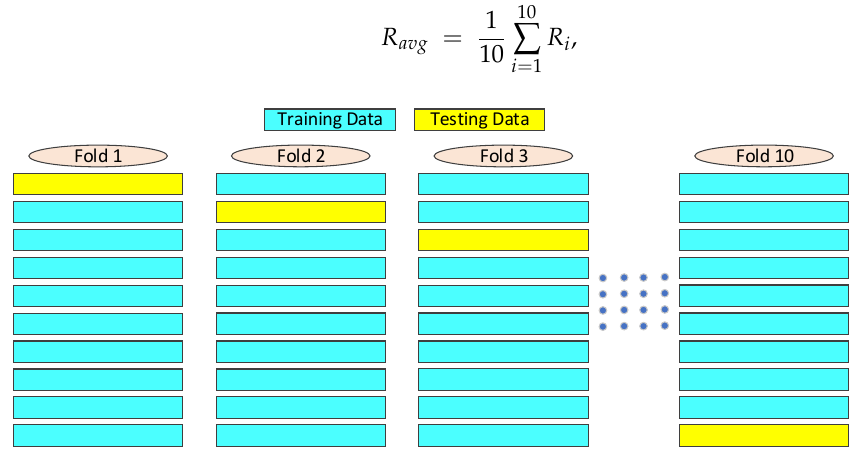
Figure 10. Schematic diagram of ten-fold cross